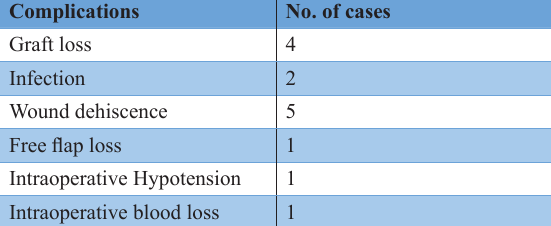
Table 5. Complication of scalp reconstruction